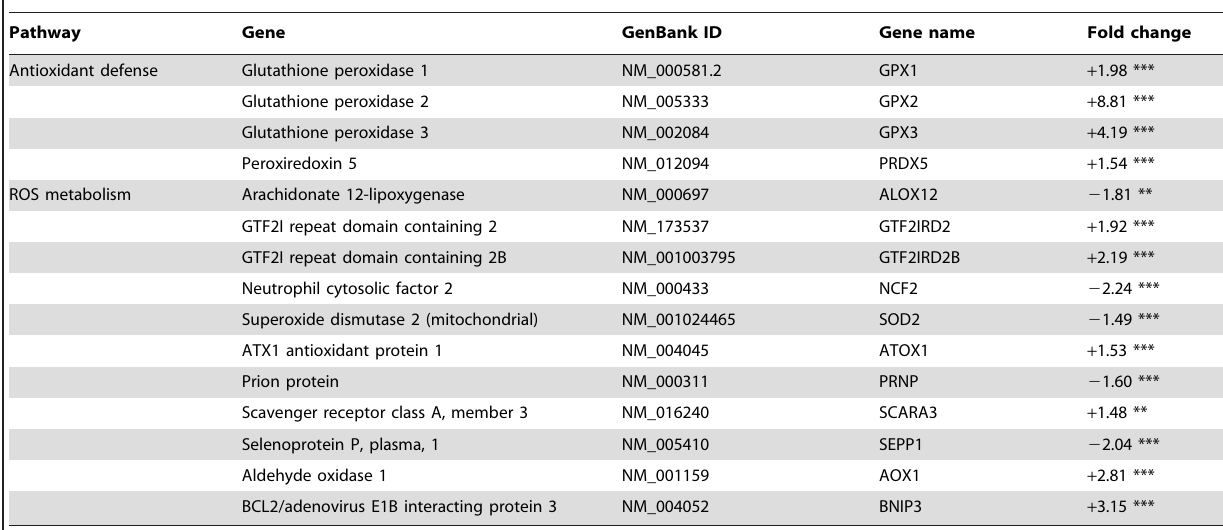
Table 3. Effect of Ets-1 over-expression in oxidative stress.